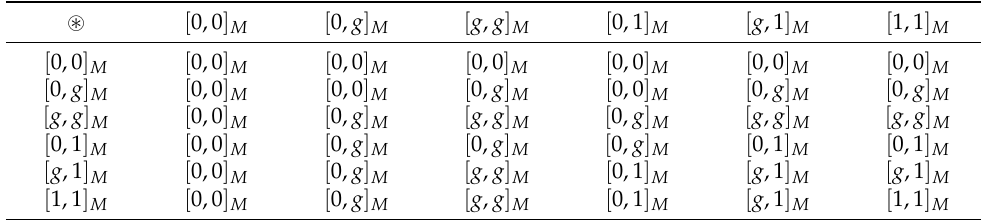
Table 7. The operation (cid:126) of algebra in Example